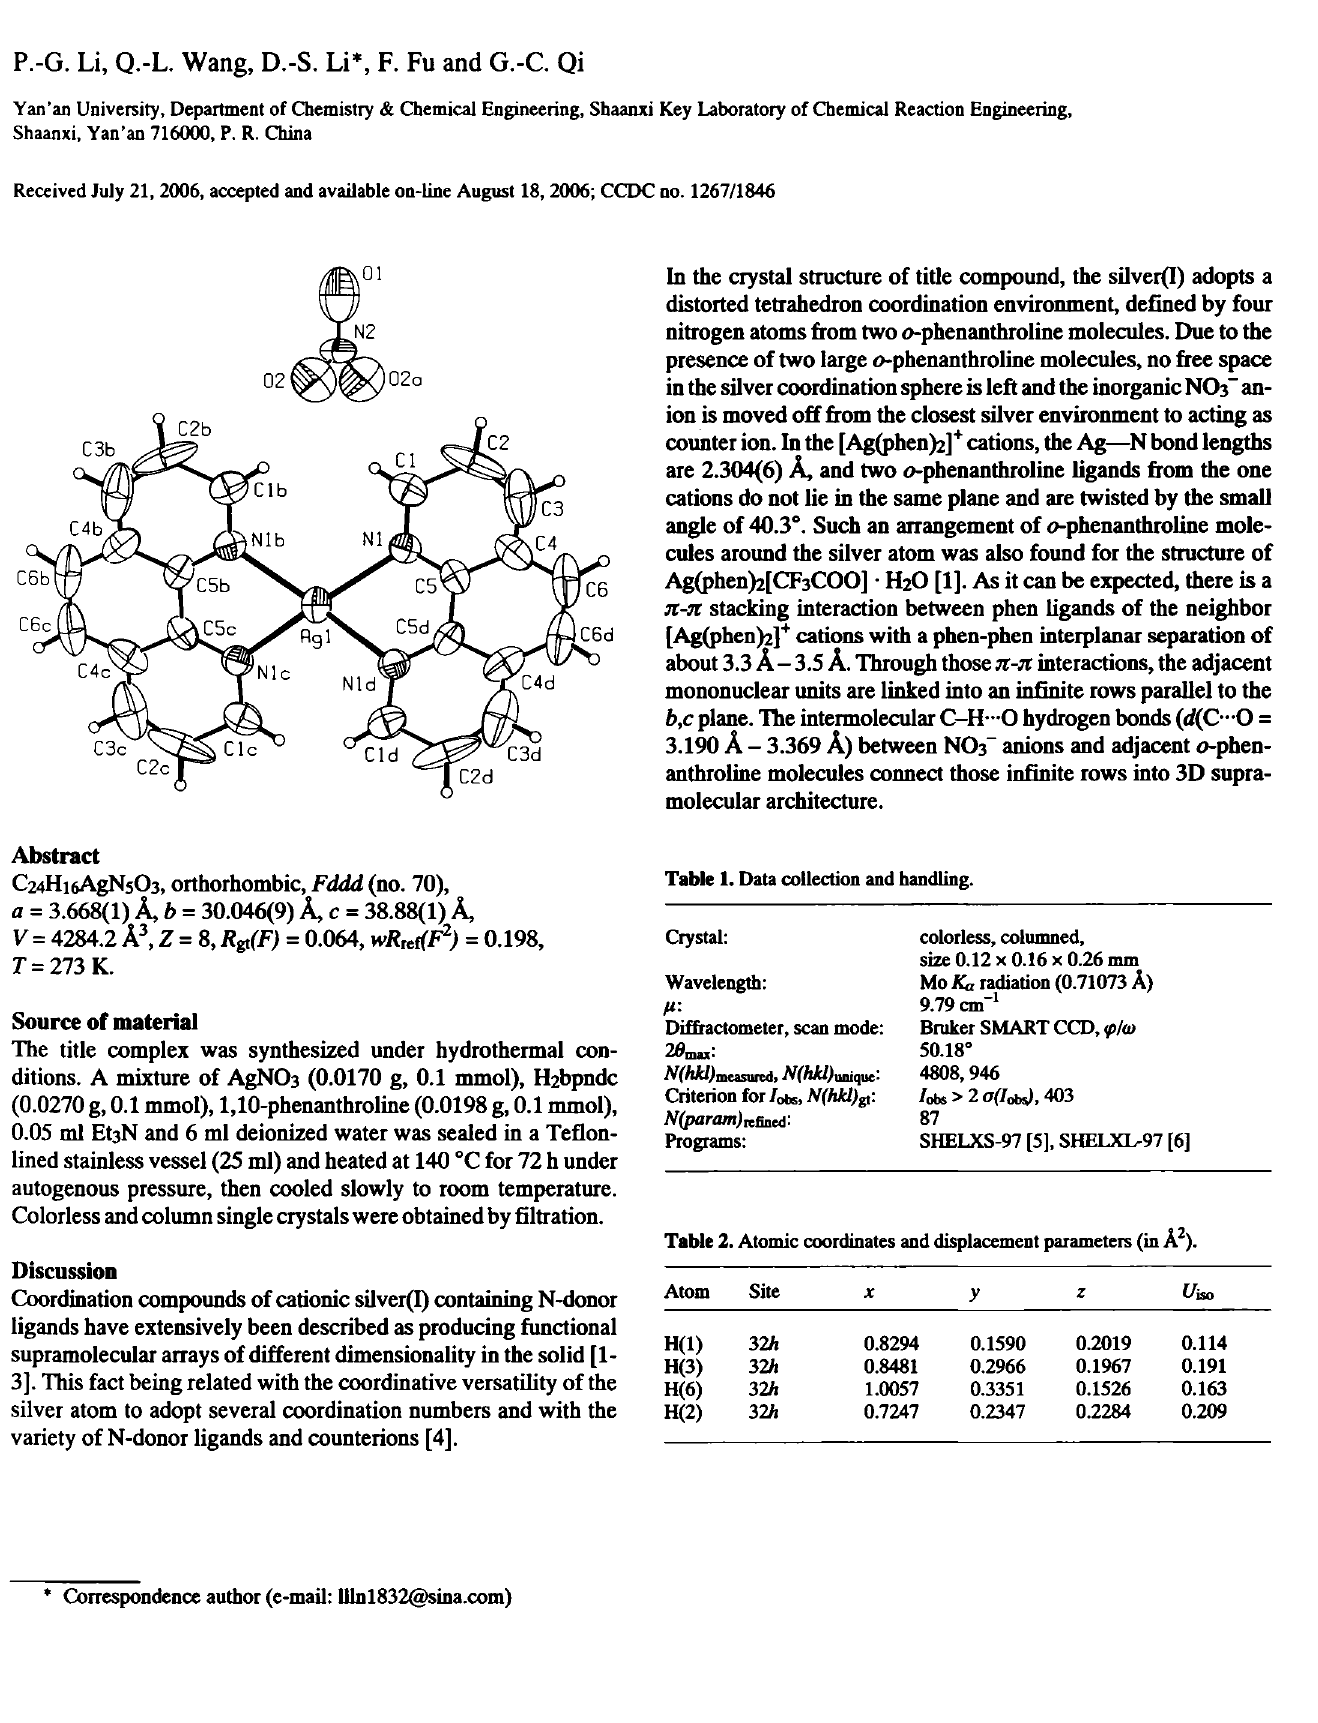
Table 2. Atomic coordinates and displacement parameters (in Ä 2